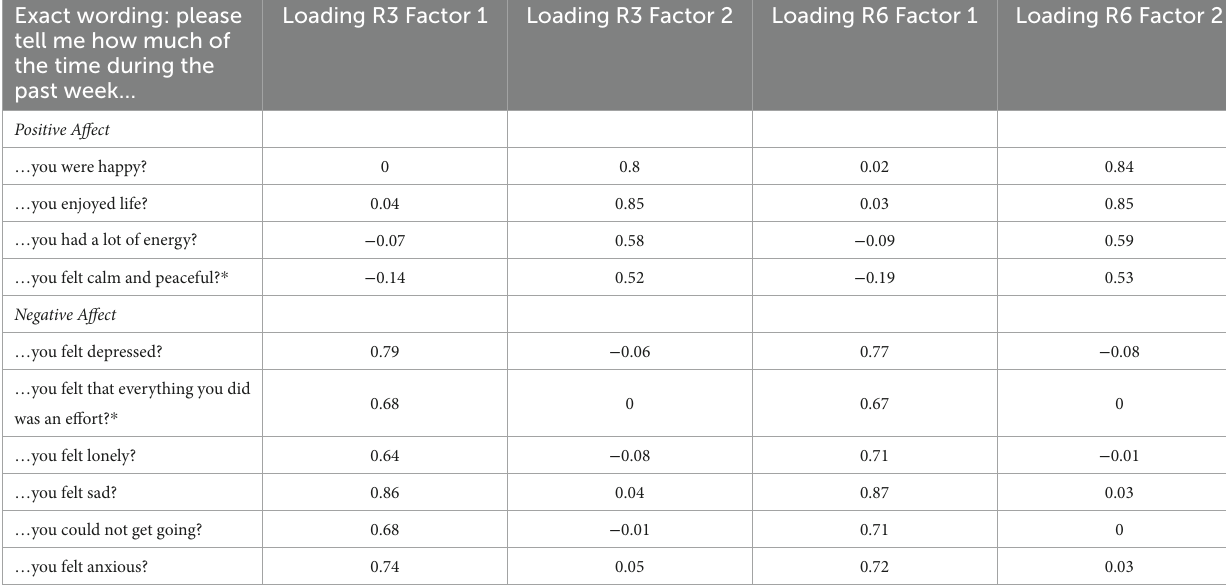
TABLE 1 Factor loadings for items measuring Positive and Negative Affect. Exact wording: please tell me how much of the time during the past week…